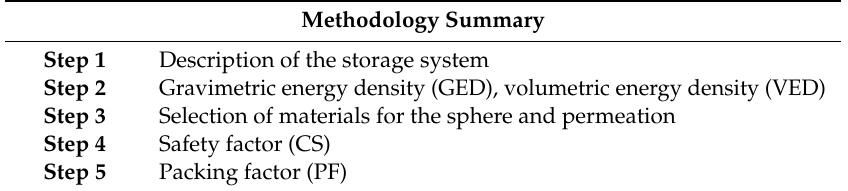
Table 3. Methodology followed to assess the performance of an innovative way to store hydrogen.